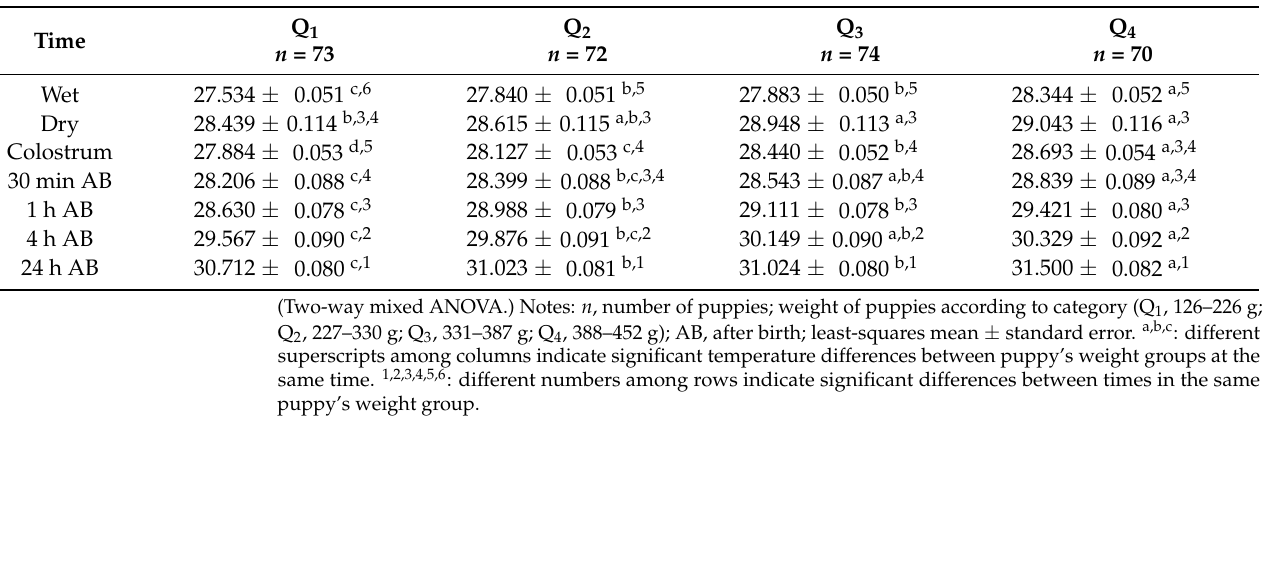
Table 7. Average of the temperature of thoracic limb biceps brachial (TLBB) window at different times in newborn puppies classified into 4 groups according to